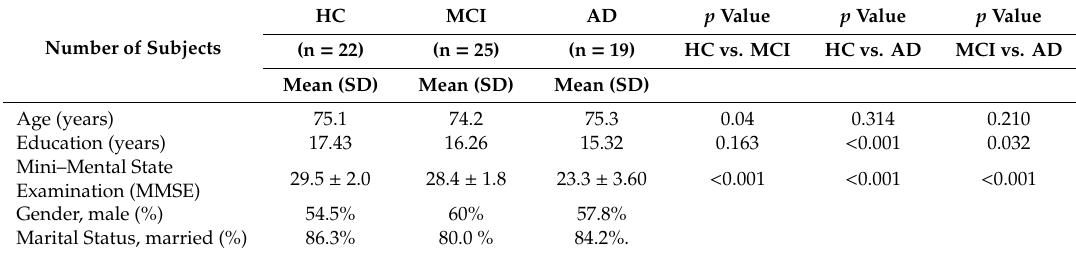
Table 1. Demographic and clinical details of the patients with AD, MCI and HCs in this